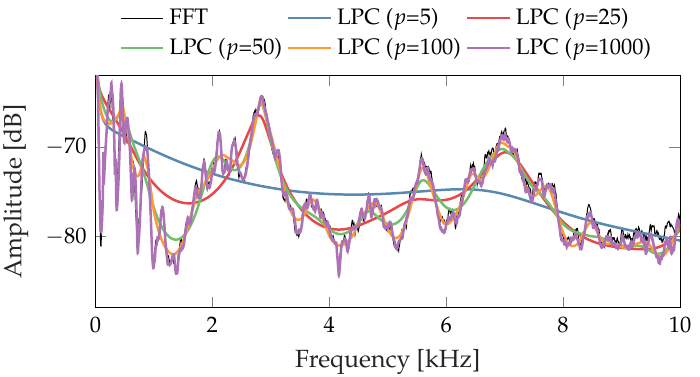
Figure 13. Comparison of the spectra via prediction coefficients of different orders p with an FFT spectrum in the frequency range up to